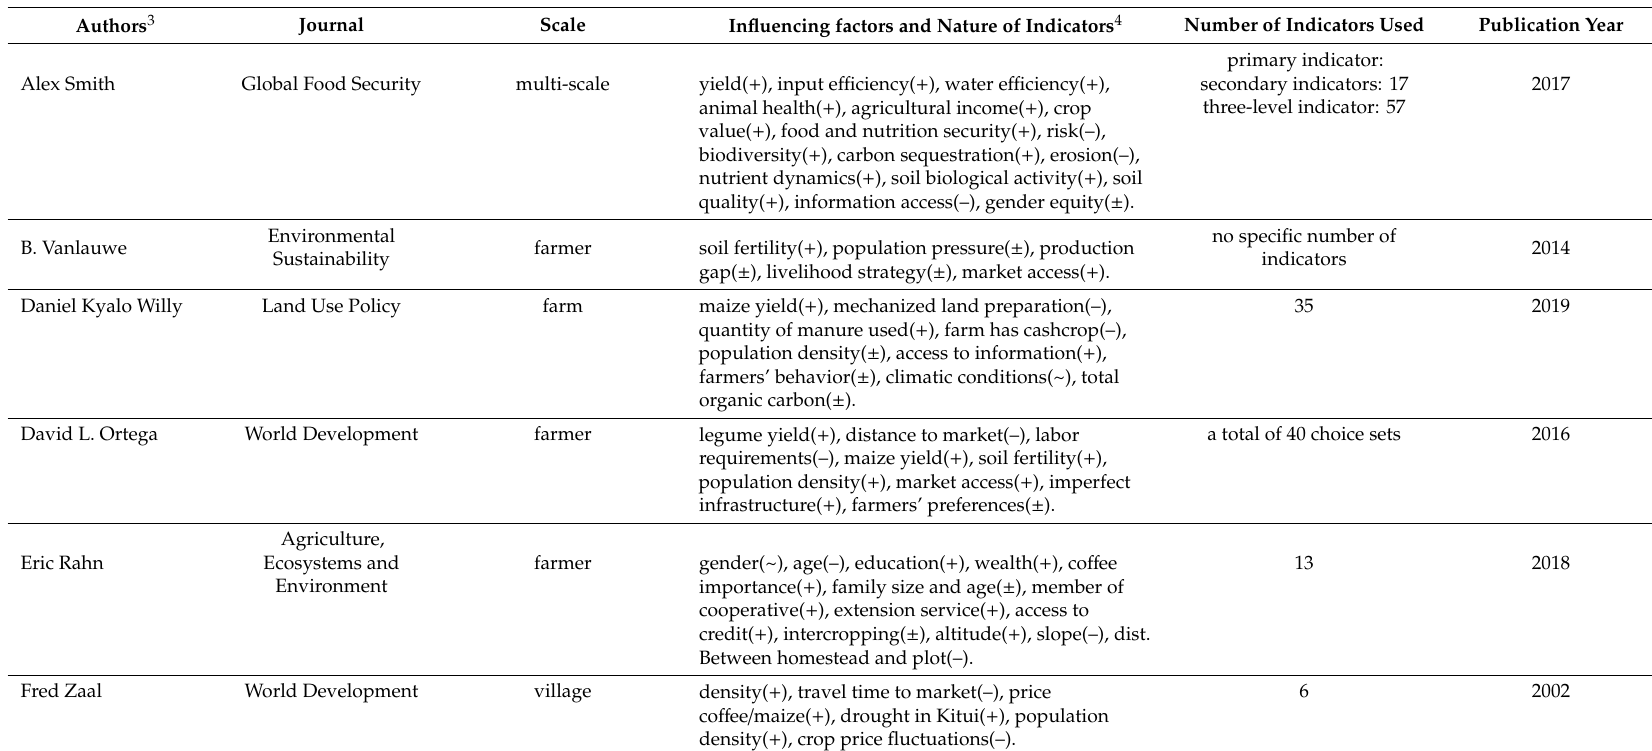
Table A2. An excerpt from the literature on agricultural sustainable intensification